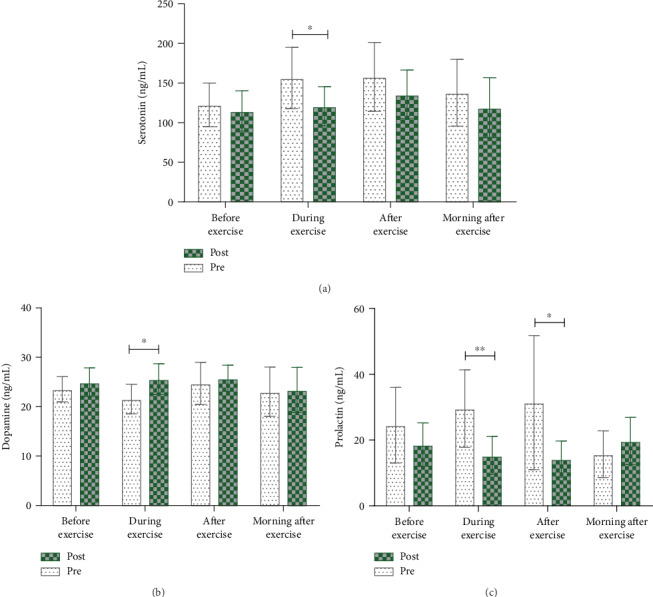
Comparison of central fatigue parameters before and after MCE supplementation during the training program. (a) Serotonin levels were lower after MCE supplementation than before MCE supplementation, particularly during exercise. (b) Dopamine levels were higher after MCE supplementation than before MCE supplementation and showed increased levels during and immediately after exercise but decreased to below rest levels in the recovery phase the next morning. (c) Prolactin levels were lower after MCE supplementation than before MCE supplementation and were higher in the recovery phase than in the rest phase. ∗p < 0.05, ∗∗p < 0.01 compared to before-MCE supplementation values.